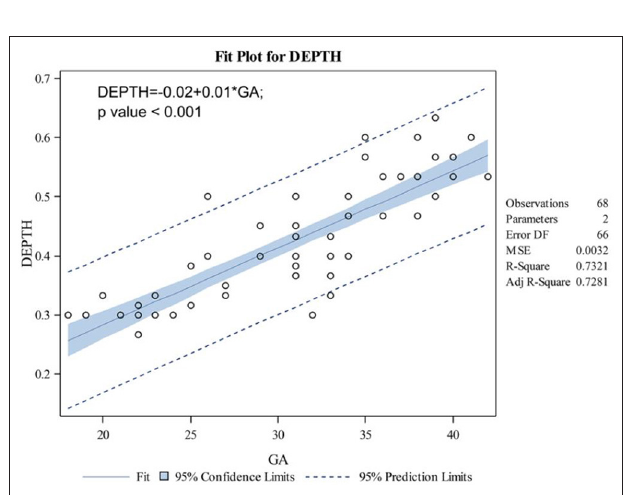
FIGURE 5 | Correlation between gestational age and acetabular